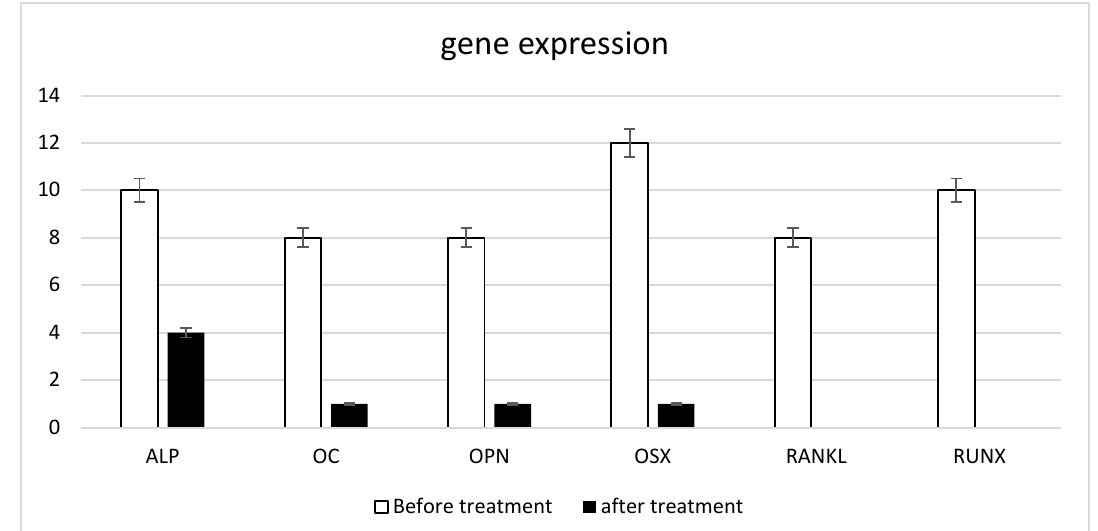
Figure 2. Gene expression profile of osteogenic markers: alkaline phosphatase (ALP), osteocalcin (OC), osteopontin (OPN), osterix (OSX), receptor activator of nuclear factor kappa-B ligand (RANKL), and run-related transcription factor 2 (RUNX).